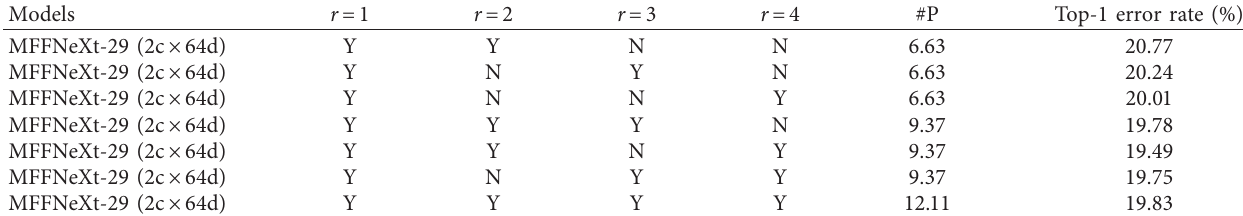
Table 5: Results for MFFNeXt-29 (2c × 64d) for combinations of different atrous rates.